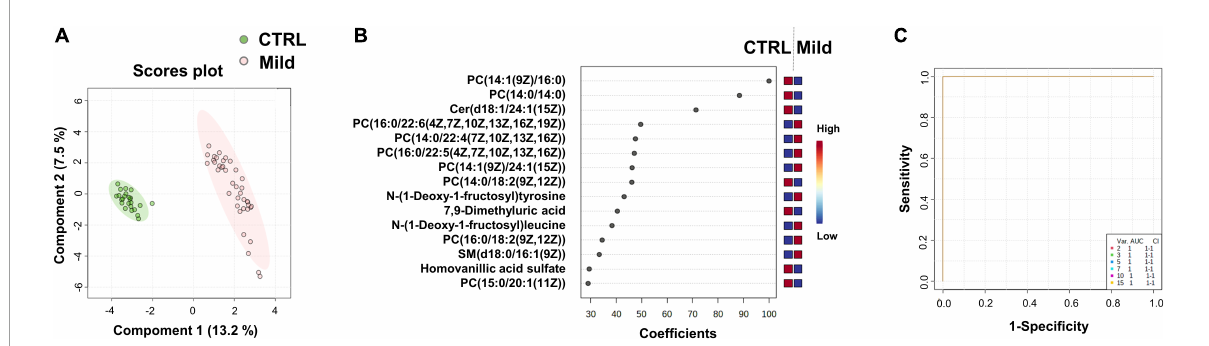
FIGURE3 Identification of putative biomarkers of mild SARS-CoV-2 infected subjects compared to healthy control subjects. PLS-DA analysis based on untargeted plasma metabolomic profiling discriminated healthy control subjects (CTRL) from mild SARS-CoV-2-infected cases (Mild). Green and red dots represent CTRL and mild SARS-CoV-2-infected subjects, respectively. The score plot is represented with a confidence ellipse of 95% (A) . Loading plots of the top 15 features (metabolites) selected on the average of the first five components of the PLS-DA model. Identified features were MS2 validated and are shown as chemical names (B) . Pairwise comparisons of areas under multivariate ROC curve (AUC) from each prognosis predictor (C) .